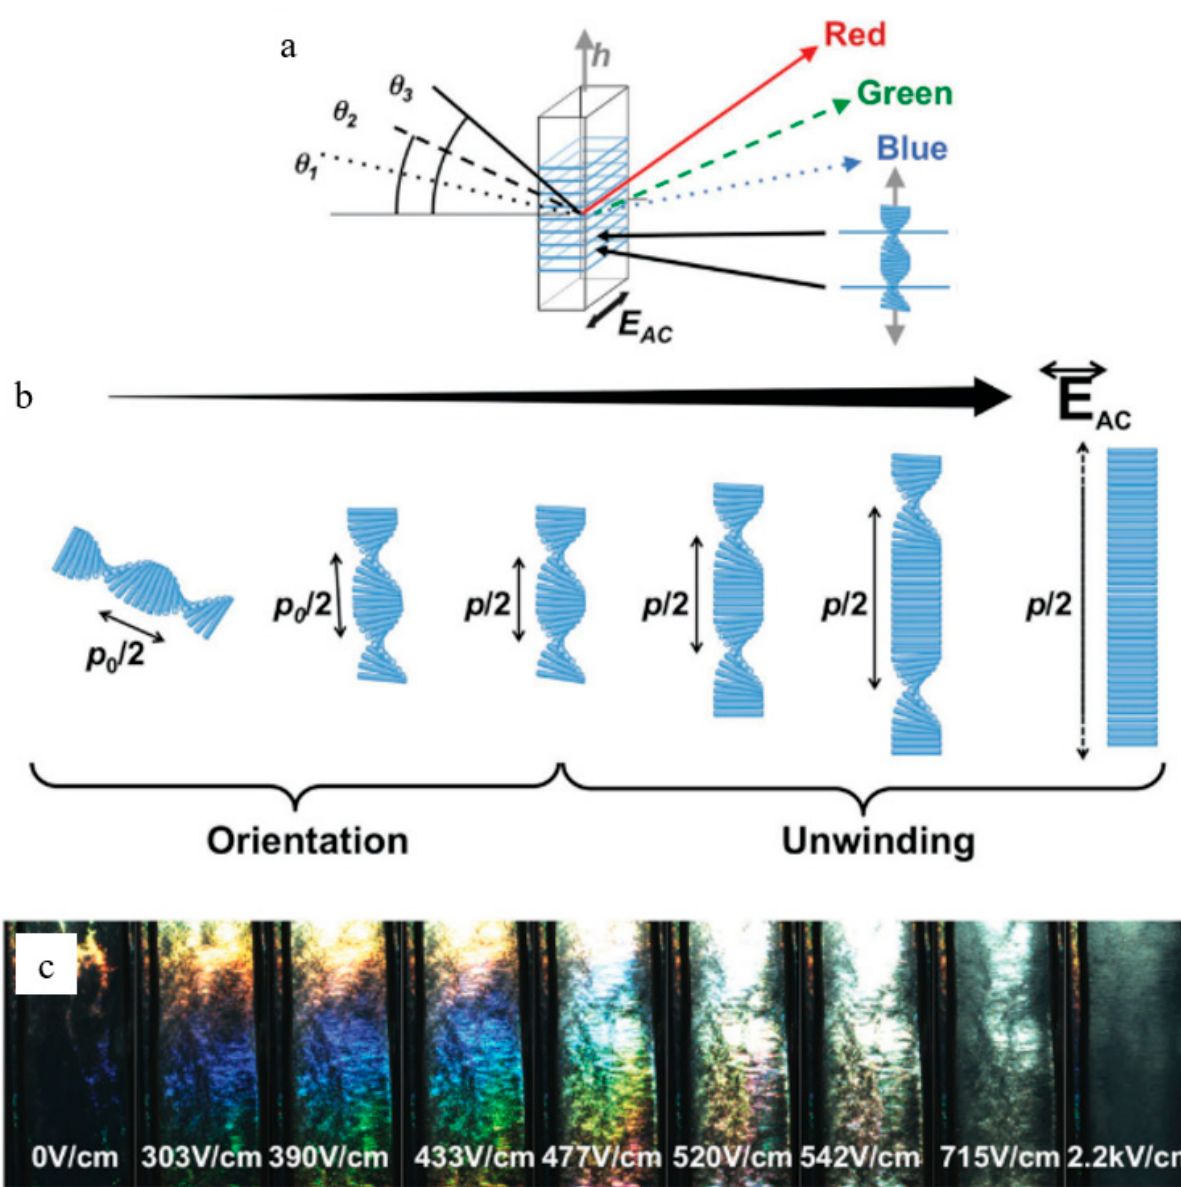
Figure 14. ( a ) Iridescence schemata, ( b ) cholesteric orientation and unwinding sequences upon the increase in the electric field, and ( c ) iridescence evolution upon electric field application (values in rms), demonstrating increased in light intensity, then redshift, and lastly color disappearance. Reproduced from